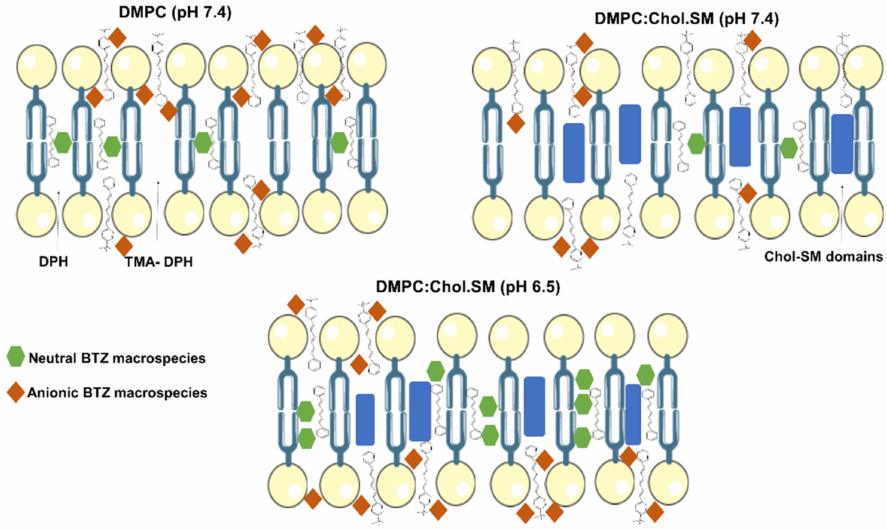
Figure 4. Schematic representation of anionic and neutral microspecies of BTZ with the TMA-DPH and DPH probes in the different studied LUVs